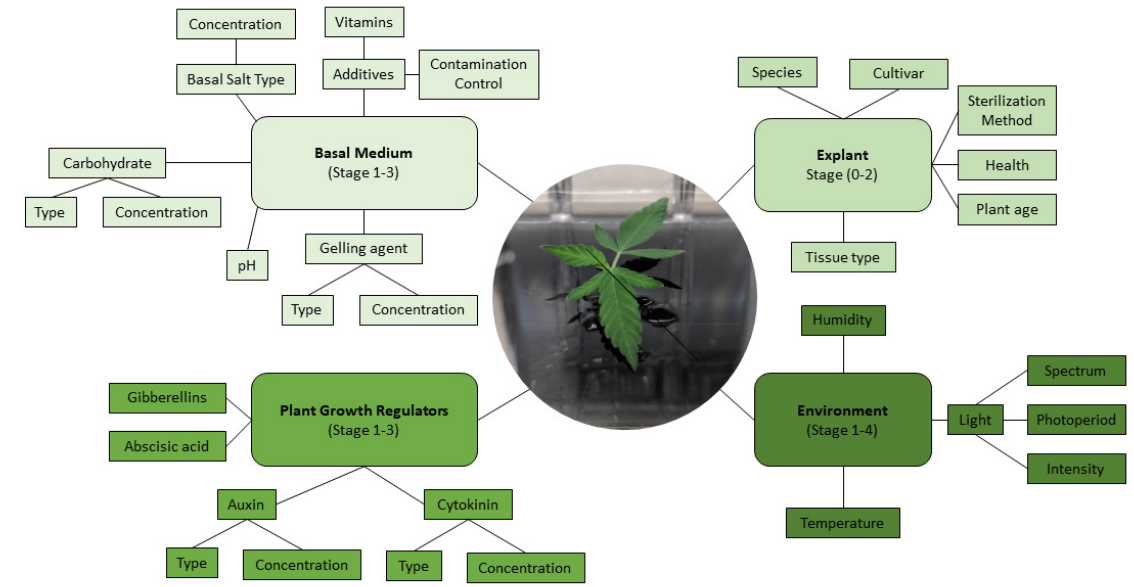
Figure 5. Tissue culture of healthy explants relies on the careful optimization of multiple factors. Center image: Freshly subcultured vegetative explant of C. sativa .